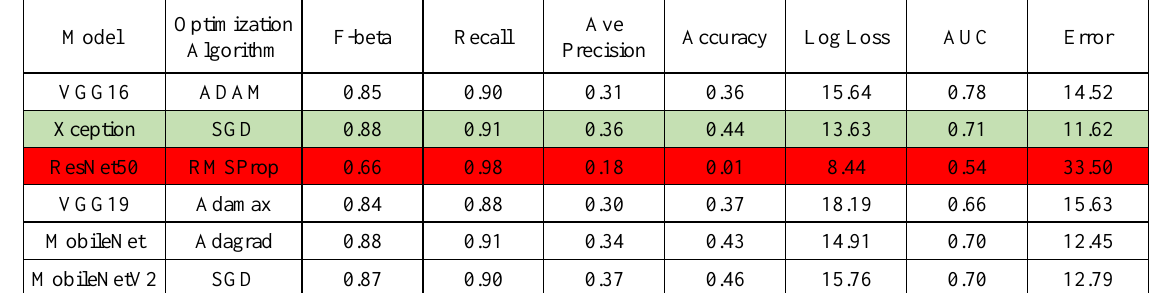
Table 1 . Number of parameters of the examined neural networks.